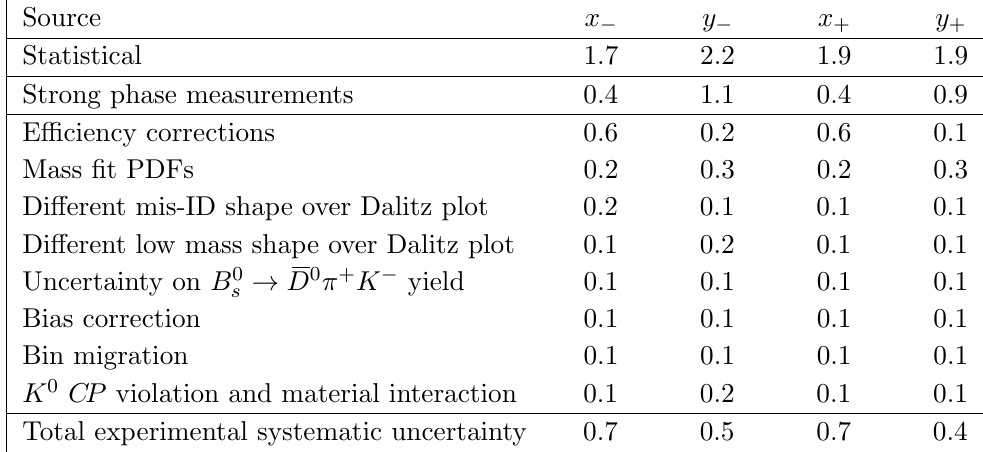
Table 3 . Summary of uncertainties for the parameters x (cid:6) and y (cid:6) . The various sources of systematic uncertainties are described in the main text. All entries are given in multiples of 10 (cid:0) 2